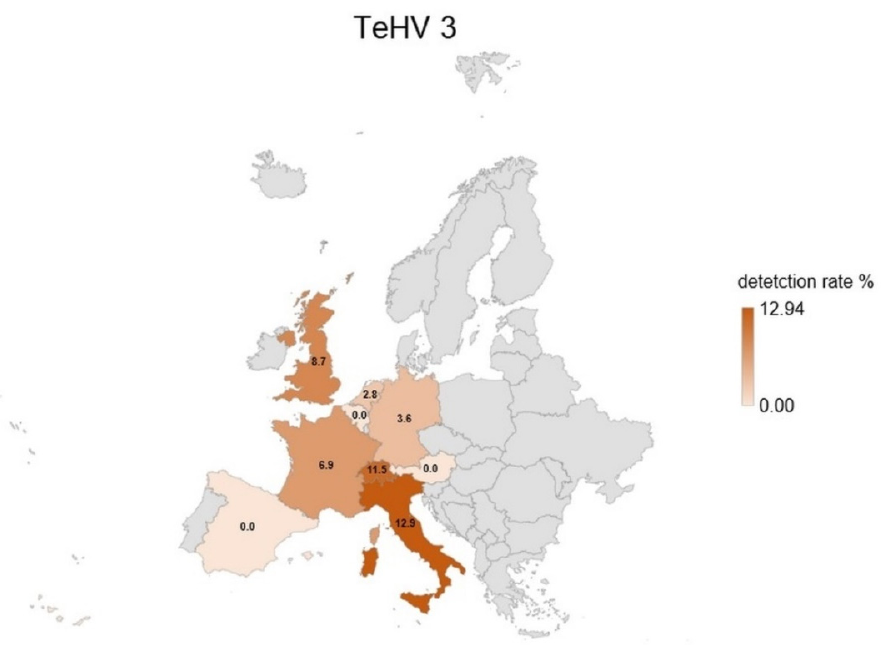
Figure 1. Herpesvirus (TeHV1 and TeHV3) antibody detection rates (titer 2 or higher) of the positive tested species (Hermann’s tortoises, Testudo hermanni ; spur-thighed tortoises , Testudo graeca ; mar- ginated tortoises , Testudo marginata ; Russian tortoises , Testudo horsfieldii ; African spurred tortoise, Centrochelys sulcata ; radiated tortoise, Astrochelys radiata ; and leopard tortoise, Stigmochelys pardalis ).